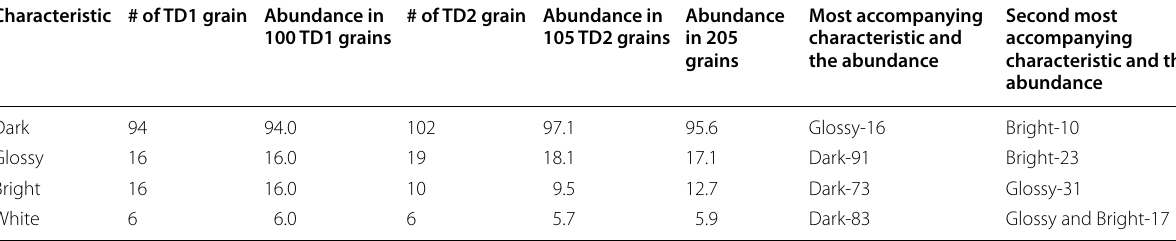
Table 1 Classification of 205 grains based on their